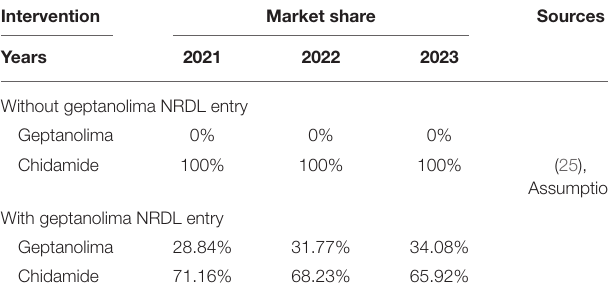
TABLE 4 | Market share